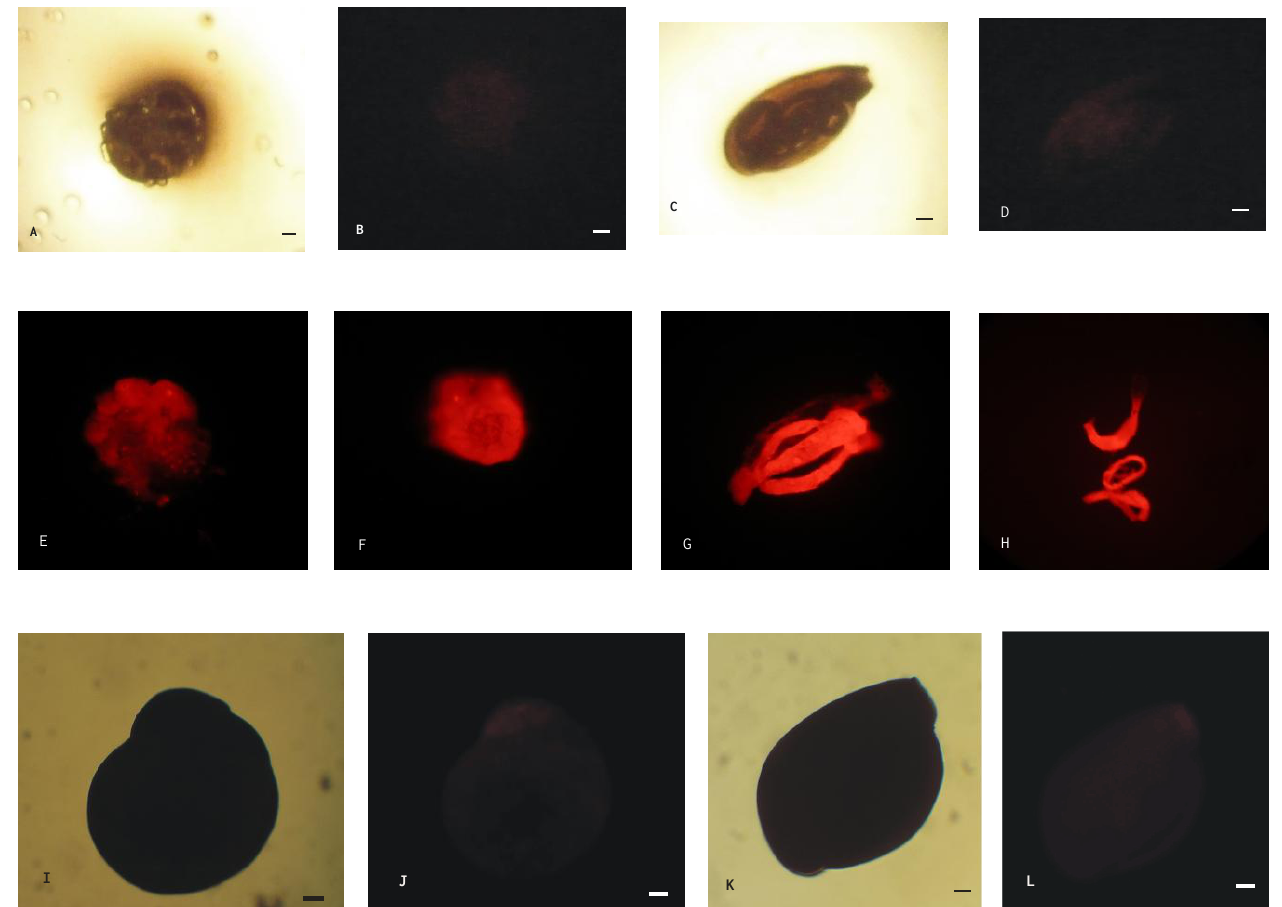
Fig. 2. Results of the experiments carried out to optimize the FISH protocol. (A) – (D) FISH performed on foraminiferal tests after removal of organic material in order to test the possibility of an hybridization between the FISH probe and some components of the shell. (A) – (B) Ammonia sp.; analyzed under optical microscopy (A) and epifluorescence microscopy (B) after hybridization with the S17 probe; (C) – (D) Miliolids group individual analyzed under optical microscopy (C) and epifluorescence microscopy (D) after hybridization with the S17 probe. (E) – (H) FISH performed on foraminiferal hard shells after EDTA fixation in order to test the possibility of hybridization between FISH probes and some components of the shell. (E) – (F) Ammonia sp. analyzed by epifluorescence microscopy after EDTA treatment and hybridization with the S17 probe (E) and EUK 1209 probe (F) ; (G) – (H) Miliolids group individuals viewed under epifluorescence microscopy after EDTA treatment and hybridization with the S17 probe (G) and EUK 1209 probe (H) . (I) – (L) FISH performed with non- sense probes to verify a possible non-specific probe binding during in situ hybridization. (I) – (J) Ammonia sp. analyzed using optical (I) and epifluorescence (J) microscopy. (K) – (L) Individual from the Miliolids group viewed under optical (K) and epifluorescence (L) microscopy. See text for details. Scale bars=12.5µm, except where